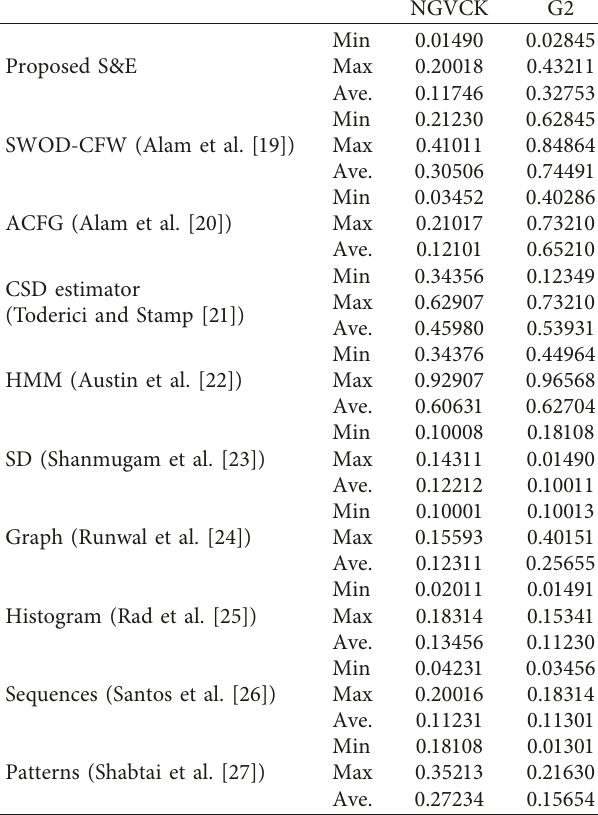
Table 3: Comparing the results of the proposed hybrid signal and encryption obfuscation (S&E) with the other